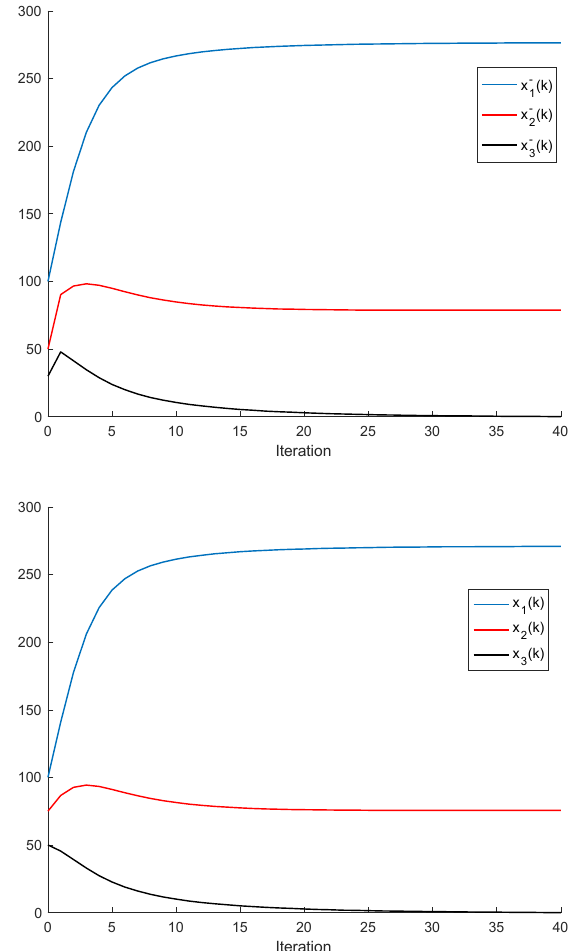
Figure 6. Evolution of x 1 ( k ), x 2 ( k ) and x 3 ( k ) for constant parameters in Example 4 when species 1 dominates the other two. In this case, there is neither harvesting nor external consumption.